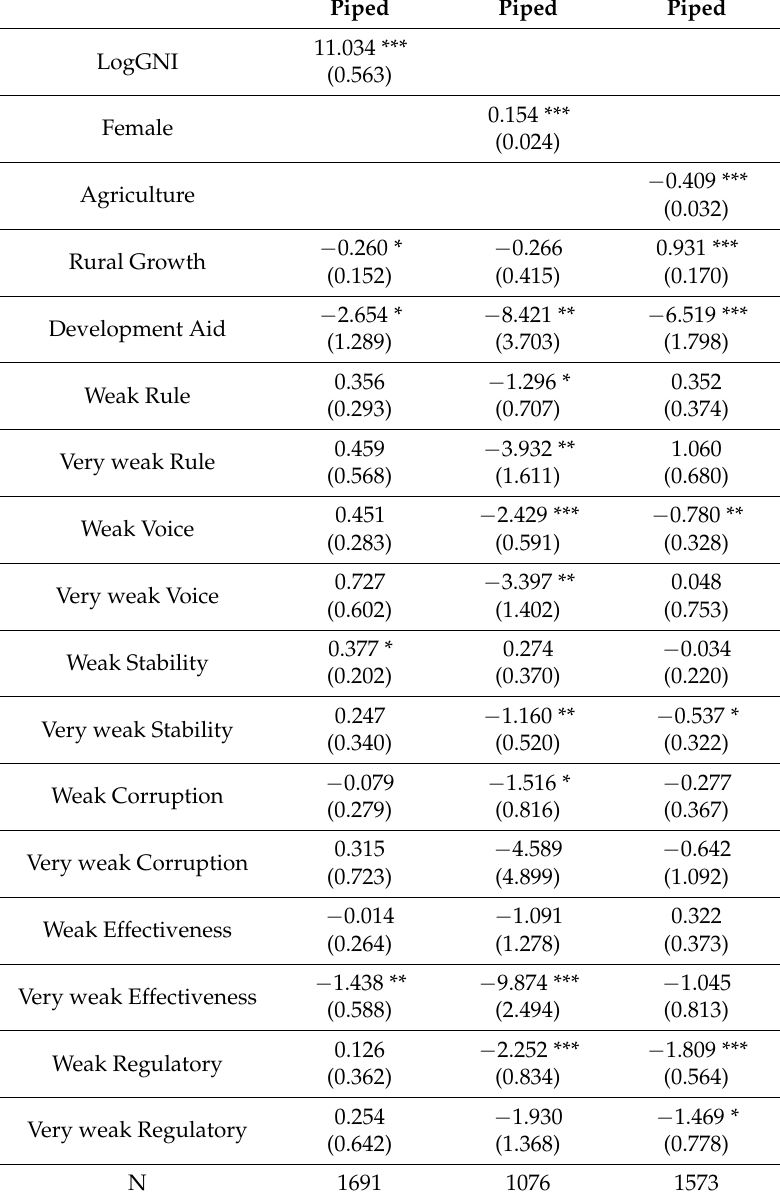
Table 3. Socioeconomic indicators. Global Data. Piped water